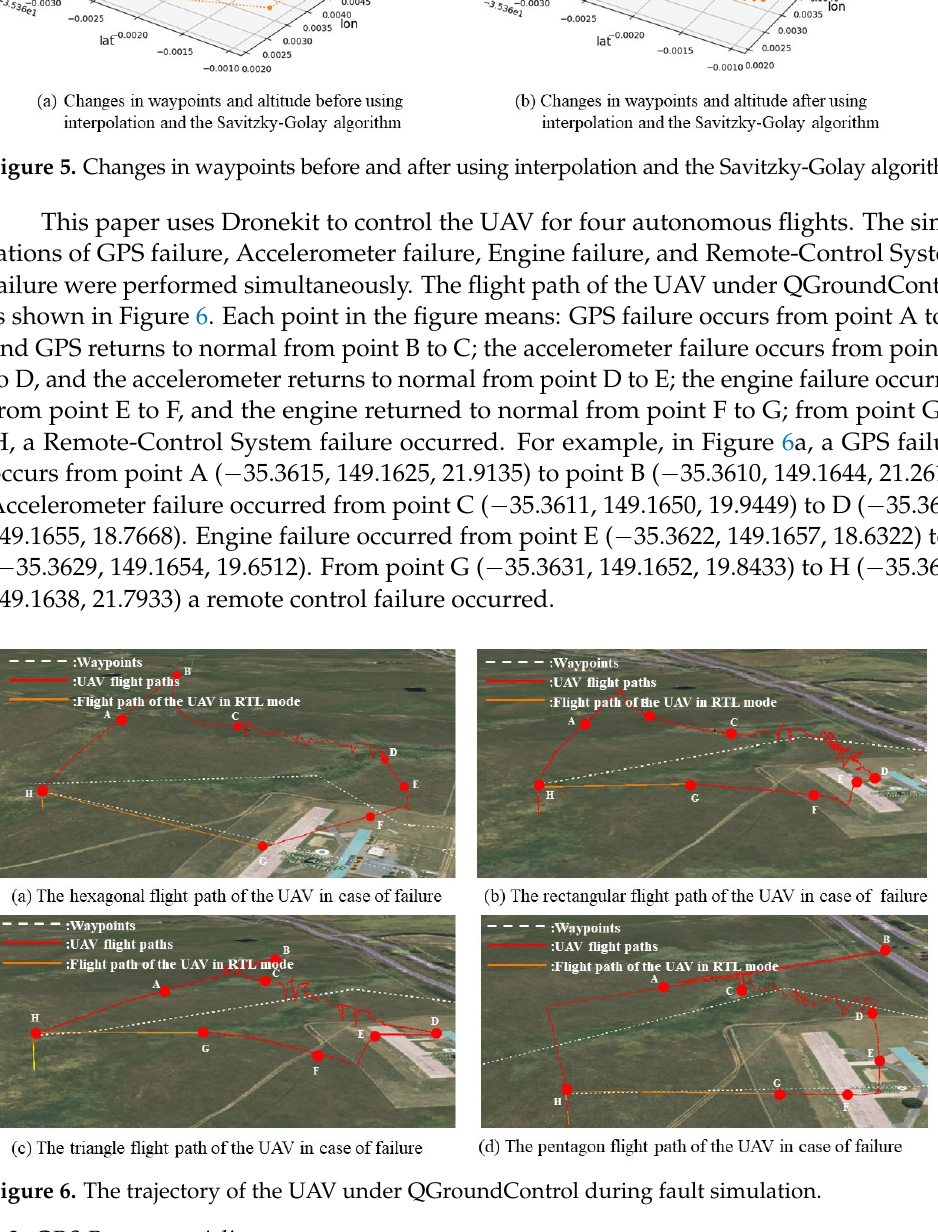
Figure 6. the trajectory of the UAV under QGroundControl during fault simulation.